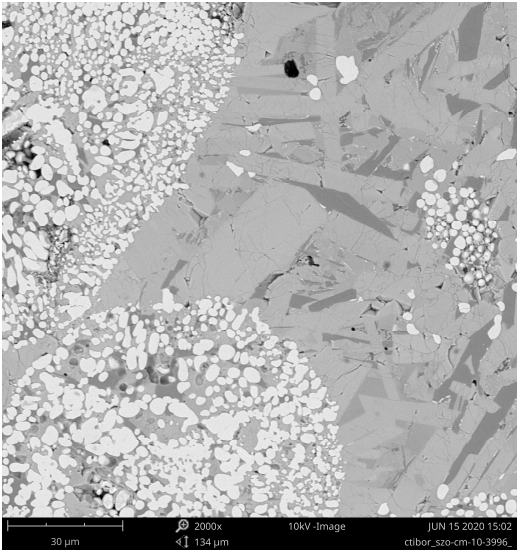
Figure 9. SEM-BSE of the sintered mixture of powders, polished cross section.